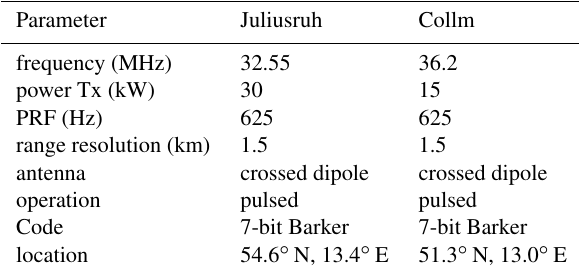
Table 1. Technical specifications of the two active meteor